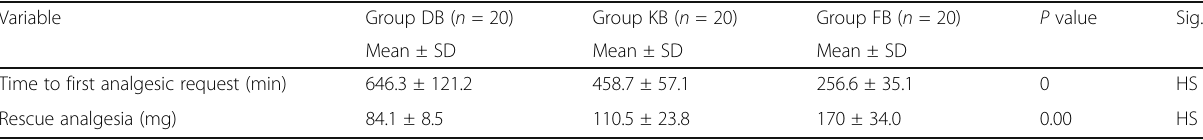
Table 3 Time for the first request of analgesia (min) and the total amount of rescue analgesia (pethidine/mg) over 24 h Variable Group DB ( n = 20) Group KB ( n =